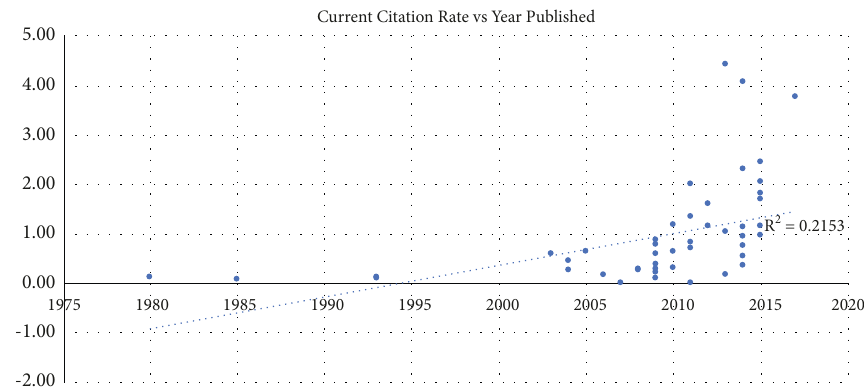
Figure 3: Current citation density vs year published.